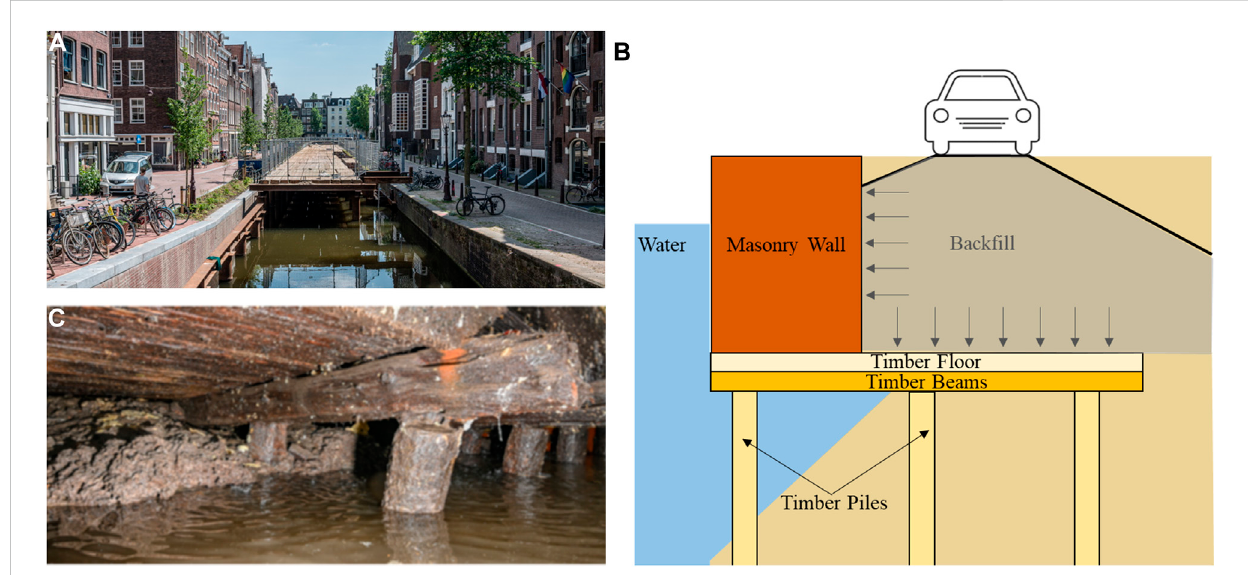
FIGURE 1 (A) Quays in Amsterdam, the Netherlands; (B) schematic cross section of quays in the Netherlands showing how vehicular traf fi c on them creates pressure distributed by the soil on quay wall structures, and (C) timber fl oor on top of a timber beam ( kespen ) connected to a timber pile [Photographs courtesy: Gemeente